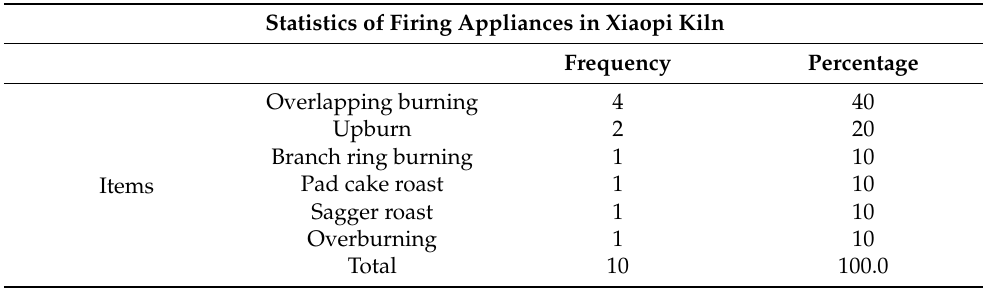
Table 6. Sampling description and statistics of ancient ceramic firing process in Xiaopi